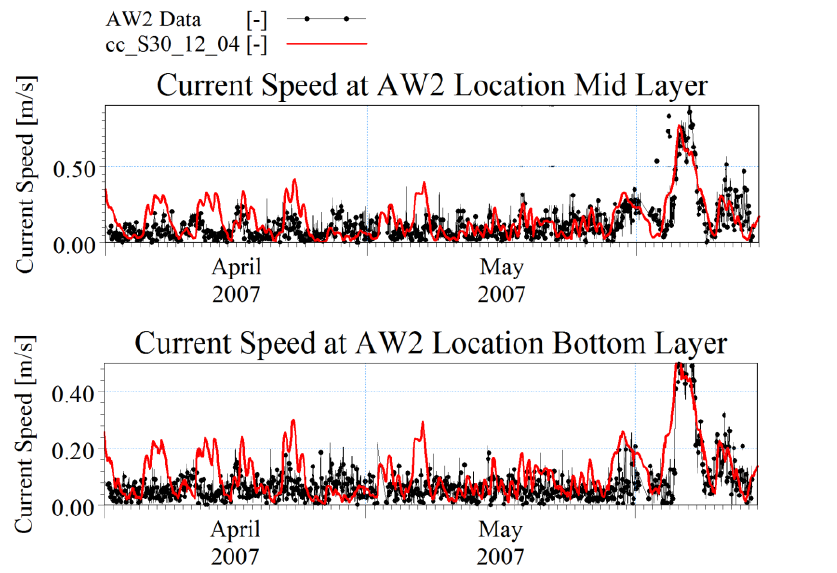
Figure 15. Comparisons on recorded (black) and simulated (red) current speed at AW2 in middle and bottom